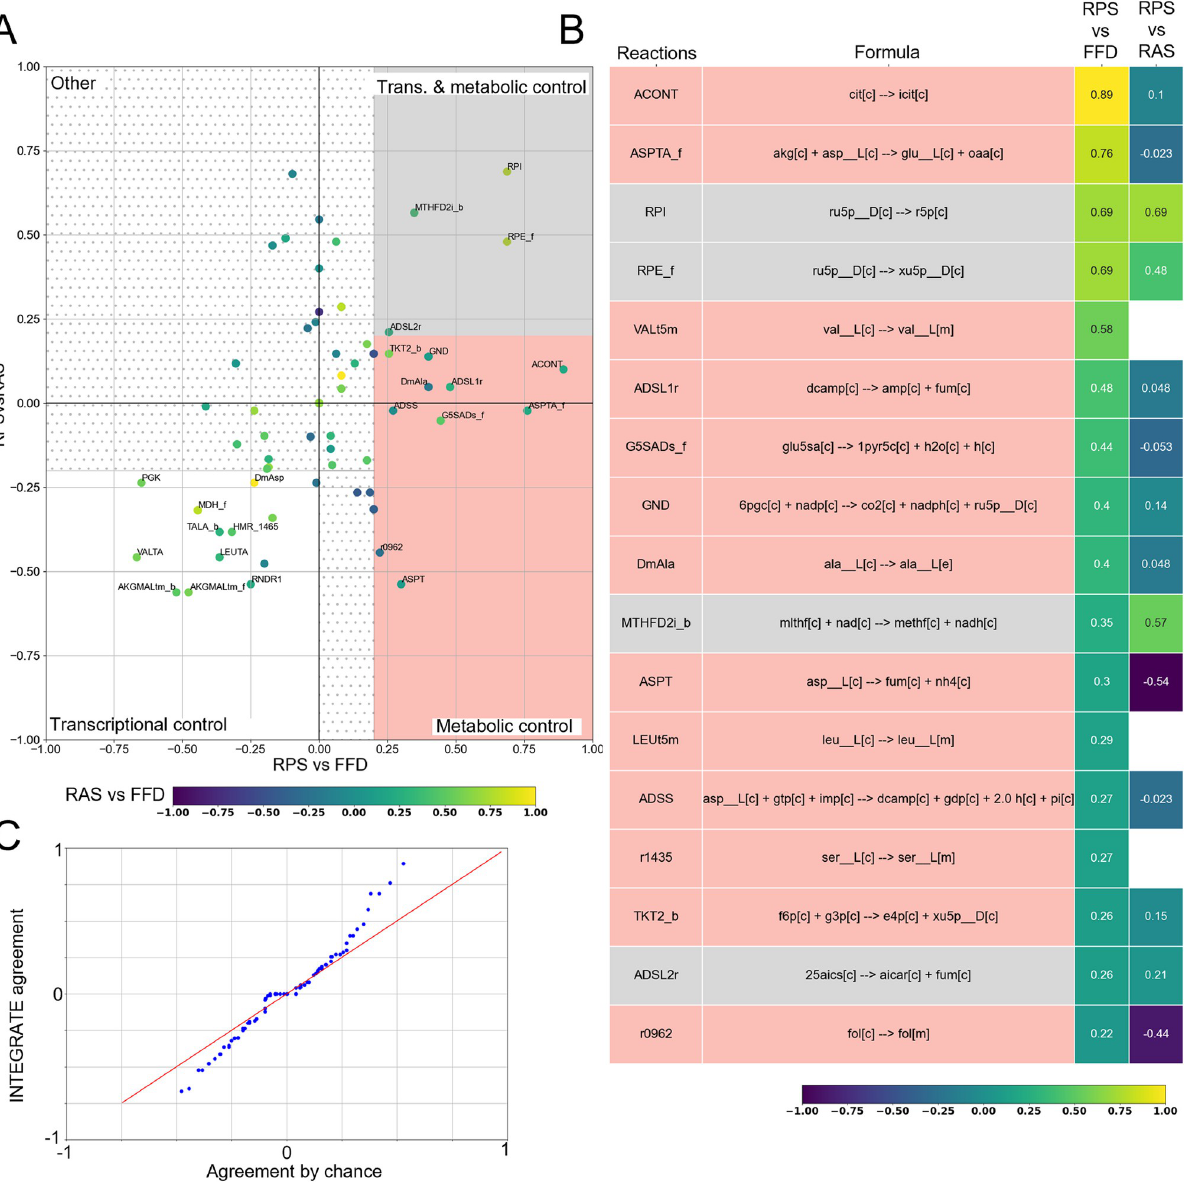
On the contrary, 13 reactions resulted only metabolically regulated because of a RPSvsFFD score above 0.2 and a RPSvsRAS score below this threshold or even missing. Missing RPSvsRAS values occur when a reaction is not associated with a GPR. In Fig 5A the mean RPS (on the left) and the FFD (on the right) of the previously identified reactions resulting from a consistent transcriptional and metabolic regulation or only